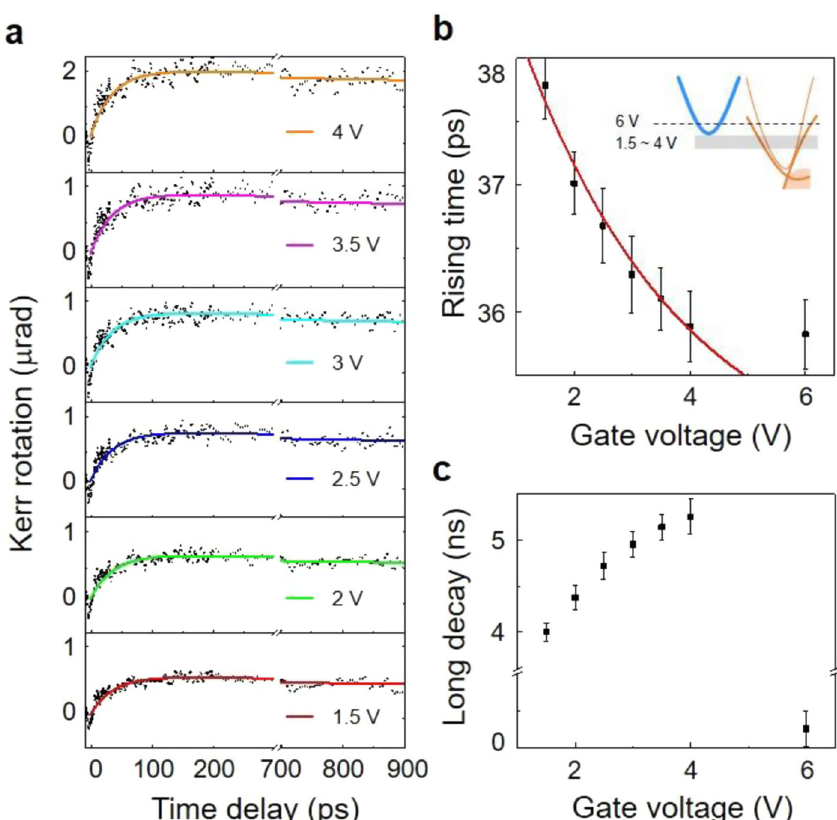
Fig. 4 Gate-dependent Kerr-rotation dynamics. a Time-resolved Kerr-rotation dynamics are shown with increasing V G from − 1.5 to 4 V. Dots are the measured data, and the solid lines are the fi tting curves. b The V G dependence of the rising time constant acquired from fi ttings in ( a ) (black dot with error bar). The obtained time constant is compared with the theoretical expectation (red line, not a fi tting curve) computed from the valley Hall conductivity (Eq. (1)). Inset: the schematic energy diagram when the V G = 1.5 – 4 V (shaded area), and V G = 6 V (dashed line). c The V G dependence of the long decay time constant given by the fi tting in ( a ). The error bars indicate standard